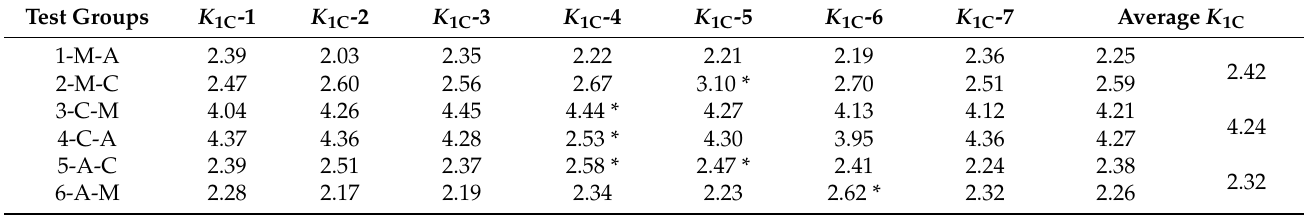
Table 4. Fracture toughness K 1C of each test group. (Unit: MPa·m 1/2 ).